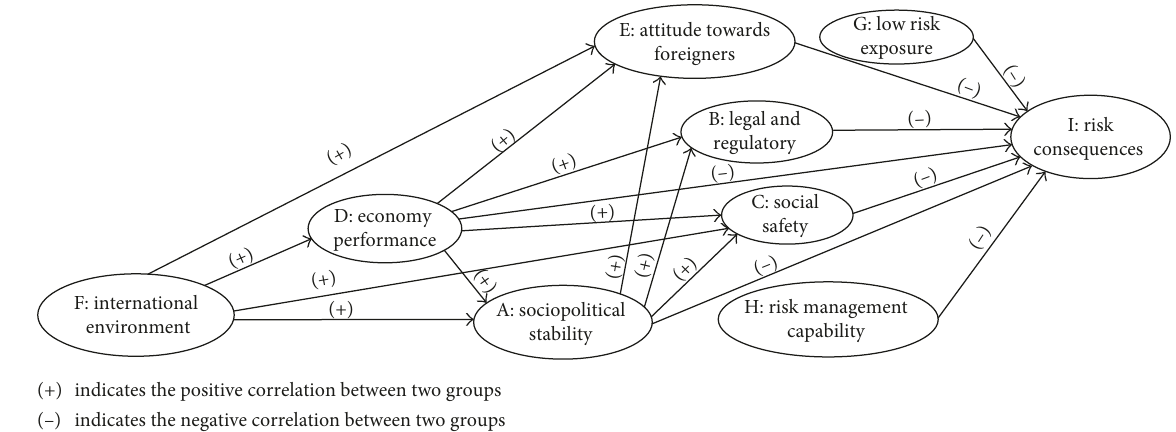
Figure 1: Hypotheses of the political risk Table 2: Profile of the respondents.